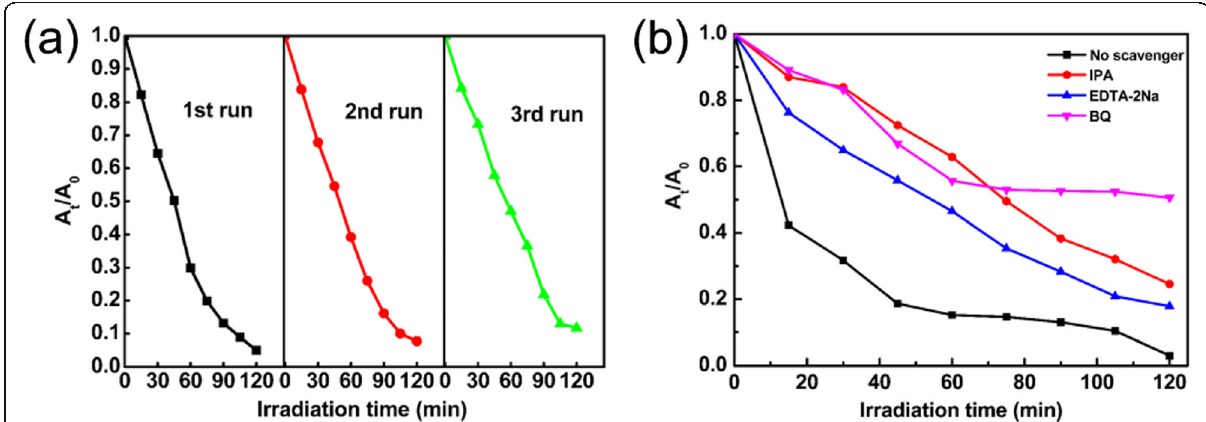
Fig. 9 ( a ) Photodegradation cycles stability of RhB (10 mg/L; 50 mL) by Bi 2 WO 6 /2 g/L GO deposited PET fabric; ( b ) Trapping experiment of active species during the degradation of RhB by